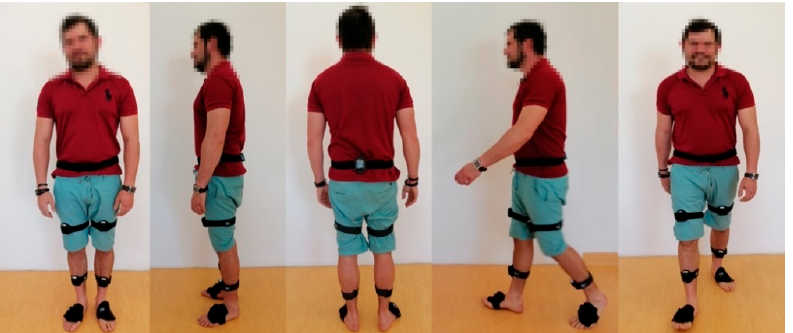
Figure 1. Patient with sensors during examination.